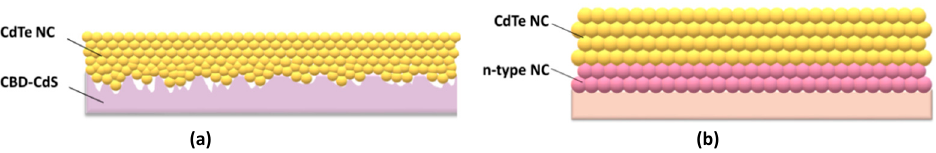
Figure 2. NC solar cells fabricated by using ( a ) CBD-CdS or ( b ) CdS NC as buffer layer.